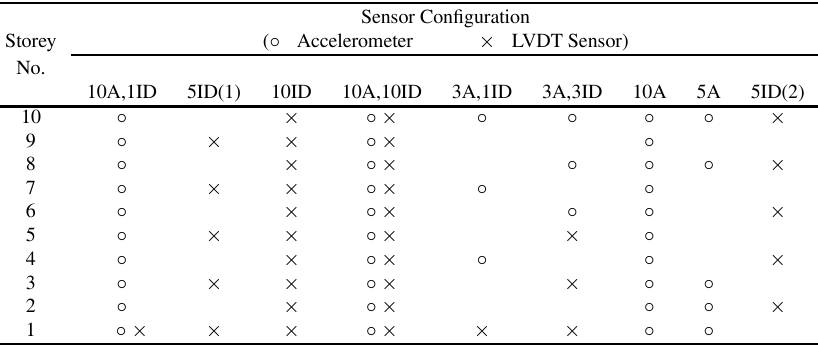
Table 3 Sensor con fi gurations with one damper